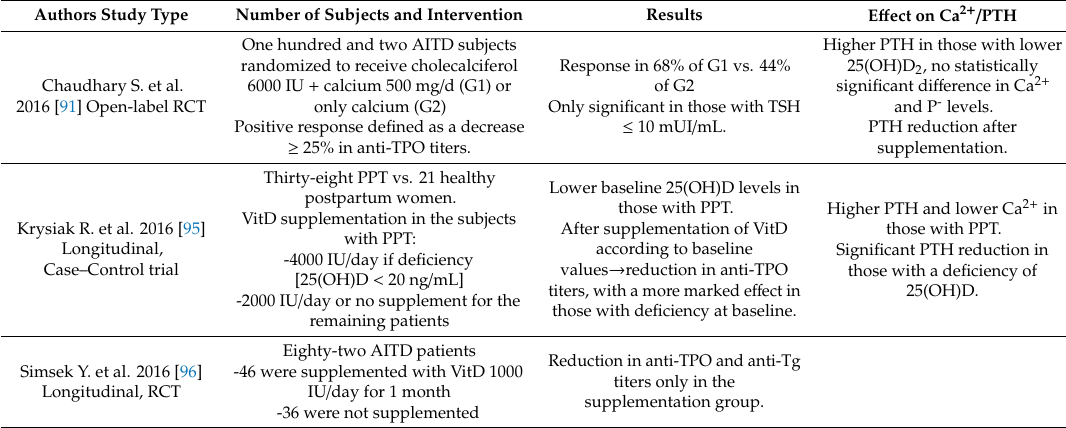
Table 2. Prospective studies on AITD and VitD